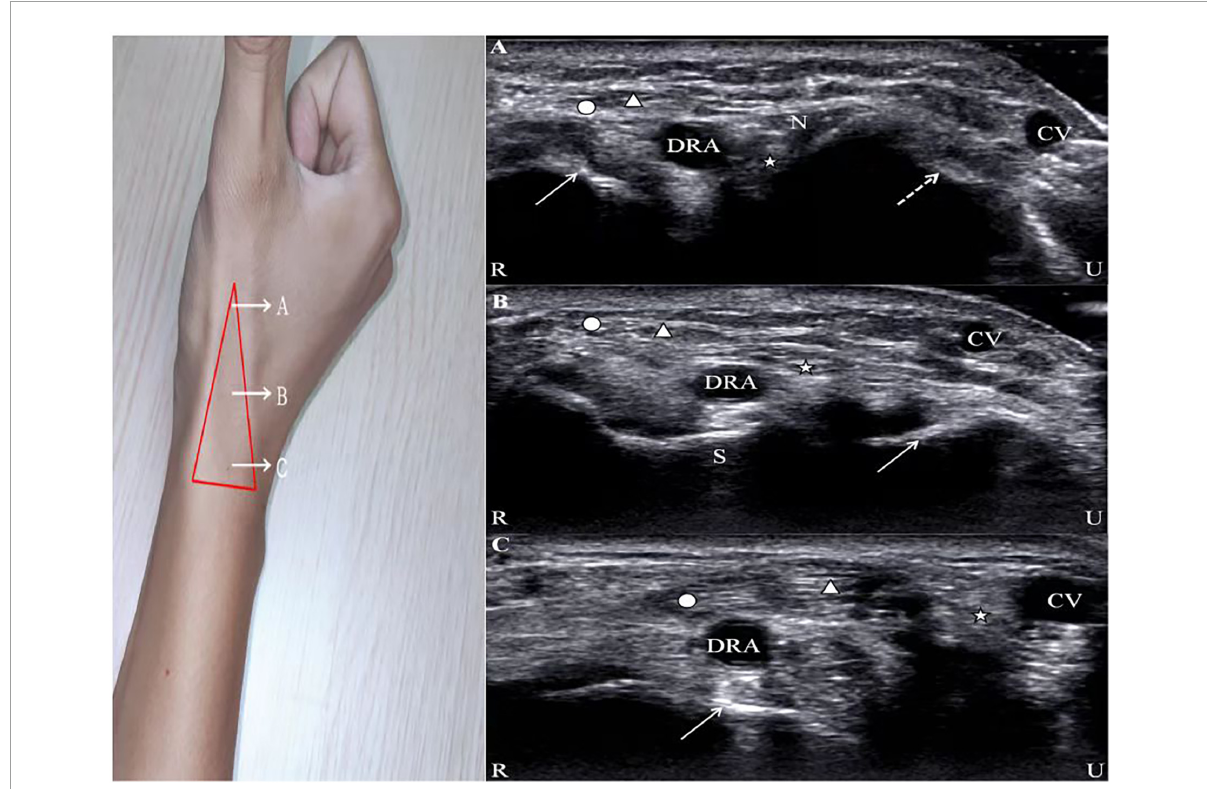
FIGURE1 Ultrasound images of the AS. Circle, abductor pollicis longus; Triangle, extensor pollicis brevis; Star, extensor pollicis longus; DRA, distal radial artery; CV, cephalic vein; R, radial; U, ulnar. (A) N, radial nerve; solid line arrow, first metacarpal bone; dotted line arrow, second metacarpal bone. (B) S, scaphoid; solid line arrow, lunate. (C) Solid line arrow, radial styloid